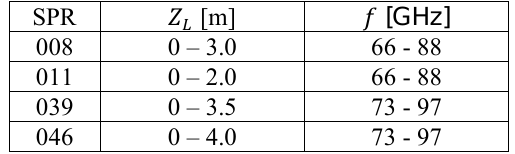
Table 2. Scan range for launch height 𝑍 𝐿 [m] and frequency f [GHz] for the EBW scans for each SPR.